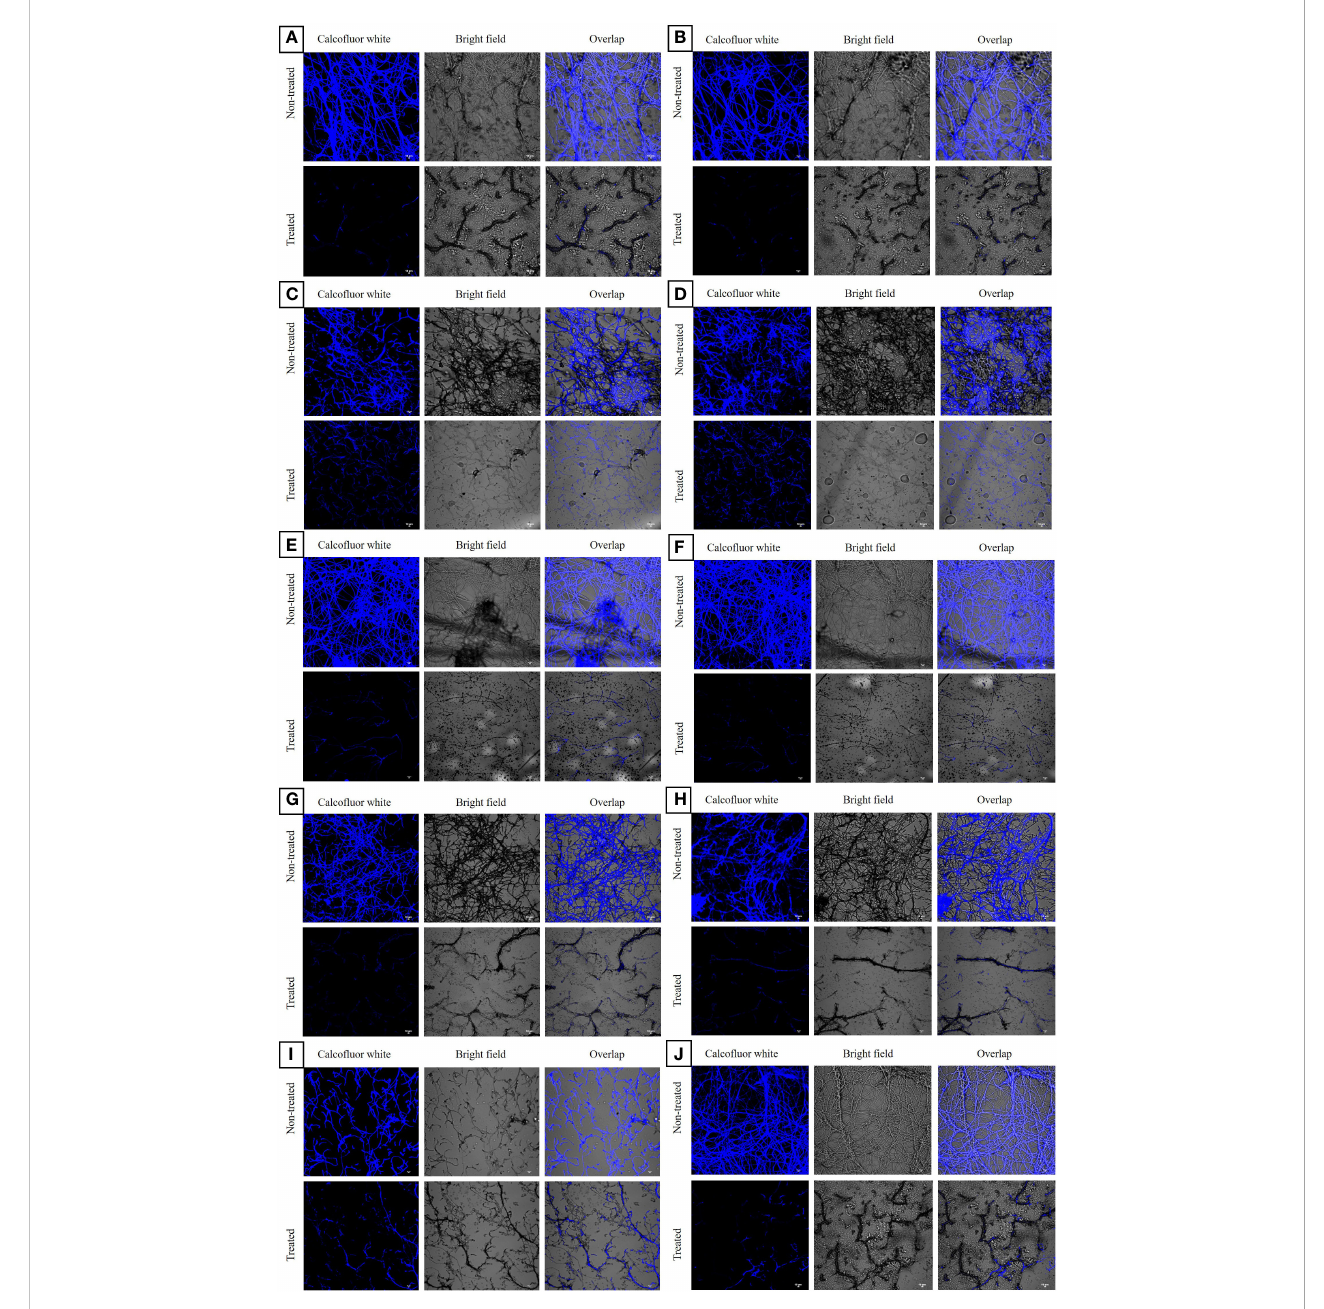
FIGURE 2 Confocal laser scanning microscopic images of bio fi lms of azole-resistant A. fumigatus isolates stained with calco fl uor white dye. It depicted eugenol untreated and treated azole-resistant (A-J) B08, Y29, RT28, B15, RB01, B03, OF26, R01, B19 and R03 isolates, respectively. In eugenol-treated samples disintegrated hyphae without ECM were observed at 20 × magni fi cation. The chitin component is stained with the calco fl uor white dye and shown in three images with and without fl uorochrome and overlapping. Scale Bar: 10 m